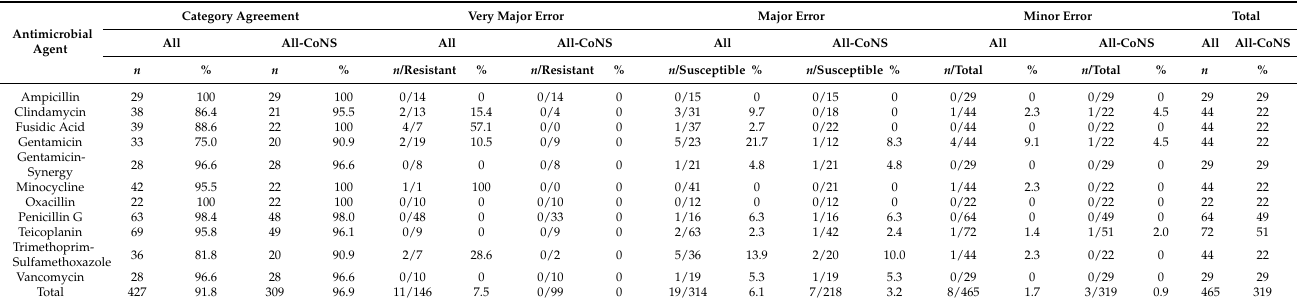
Table 4. High category agreements for the antimicrobial agent selection were identified in Streptococcus spp. isolates which were examined by the short-term (3.5 h) incubation with the BD Phoenix M50 AST system 1 . Category Agreement Very Major Error Major Error Minor Error Total Antimicrobial Agent n % n /Resistant % n /Susceptible % n /total % n Ampicillin 16 100 0/0 Ceftriaxone 29 96.7 Clindamycin 28 93.3 Penicillin G 16 Vancomycin